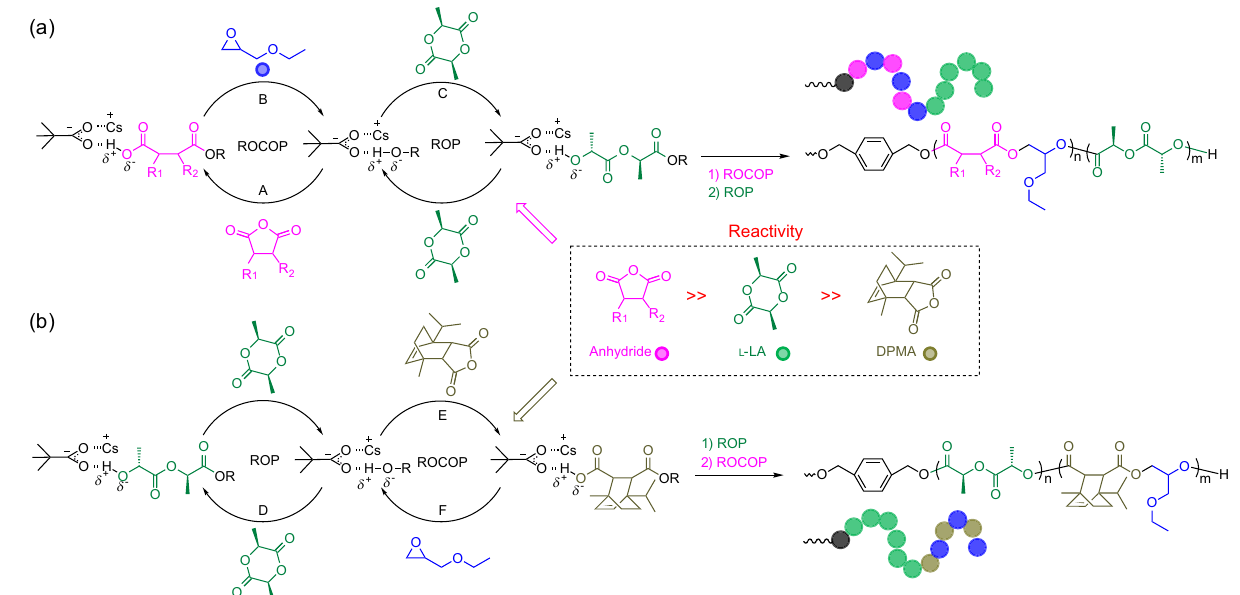
Fig. 4 Two different polymerization routes of the mixture of anhydride, epoxide, and L -LA. a The conventional route. b The present route. Green: L -LA. Blue: EGE. Olive: DPMA.